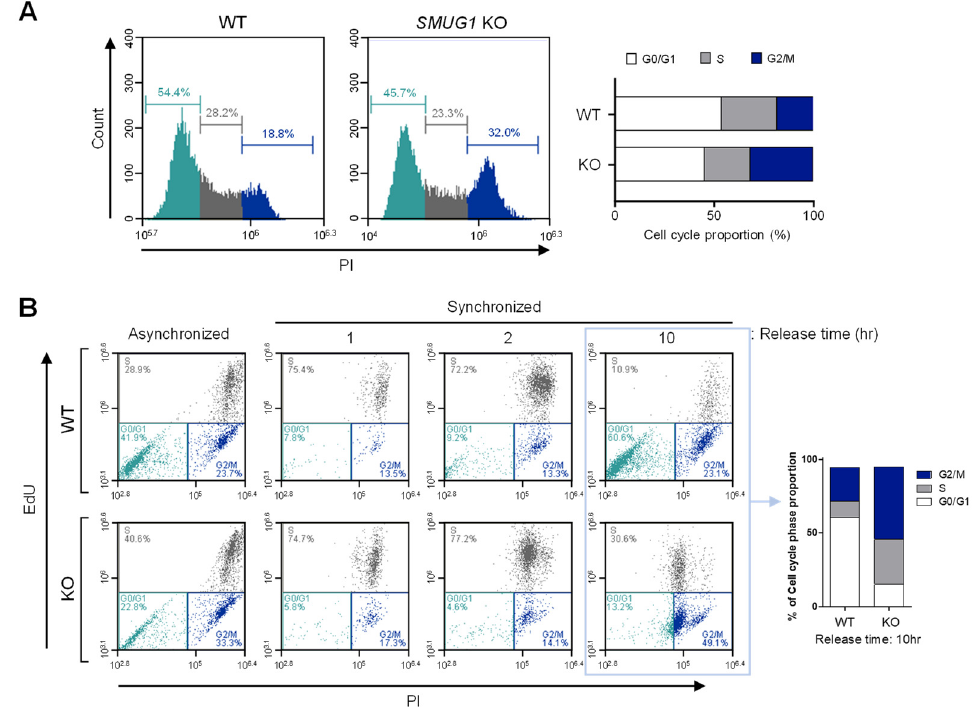
Figure 3. Ablation of SMUG1 reduces the proliferation through the cell cycle arrest at the G2/M phase. ( A ) Cell cycle assay was performed by the staining of cells with propidium iodide (PI) of asynchronized total cells. Cell cycle proportion was graphed at the right panel. The proportion of the cell cycle was assessed by flow cytometry. The scatter plots represent PI (X-axis) vs. counted cells (Y-axis). ( B ) Cell cycle of HepG2 WT and SMUG1 KO cells was synchronized using thymidine double blocking. After full synchronization of the cell cycle, cells were released from G1/S arrest with the EdU staining for the newly synthesized DNA. The proportion of the cell cycle was assessed by flow cytometry. The scatter plots represent PI (X-axis) vs. EdU stained cells (Y-axis).